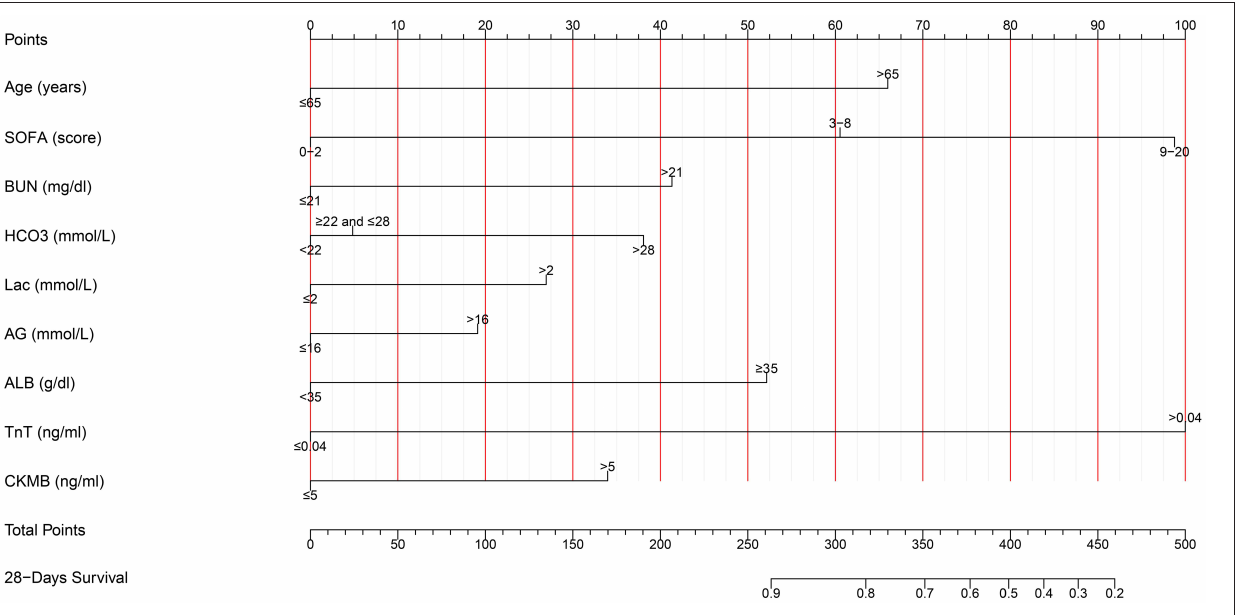
FIGURE 3 | The nomogram used for predicting the short-term mortality in intensive care patients with acute heart failure. SOFA, Sequential Organ Failure Assessment; BUN, blood urea nitrogen; TnT, troponin T; CK-MB, creatine kinase-MB; HCO − 3 , bicarbonate; Lac, lactic acid; AG, anion gap; ALB,